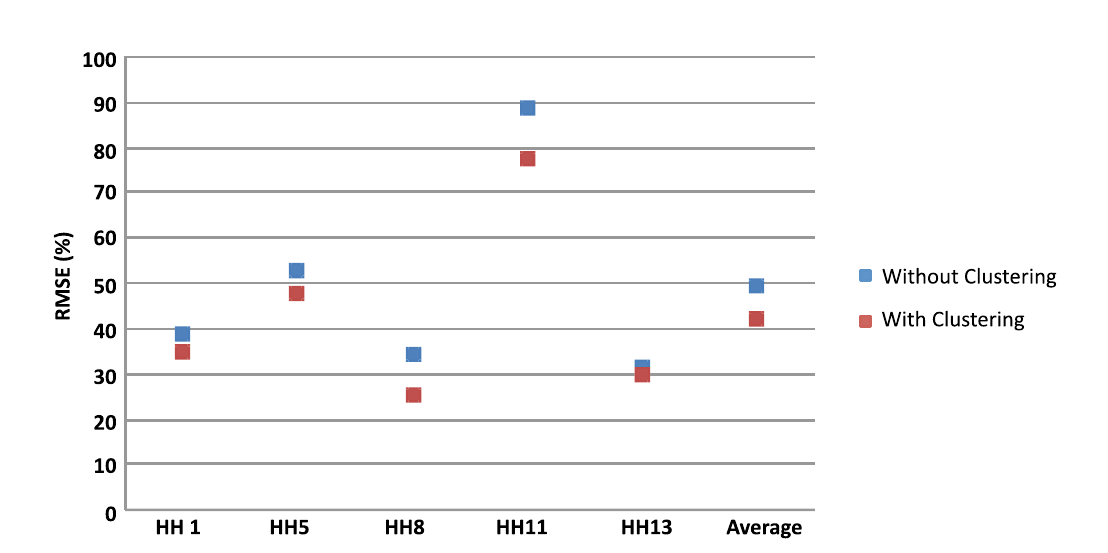
Fig. 8. Improvement of RMSE with pre-clustering